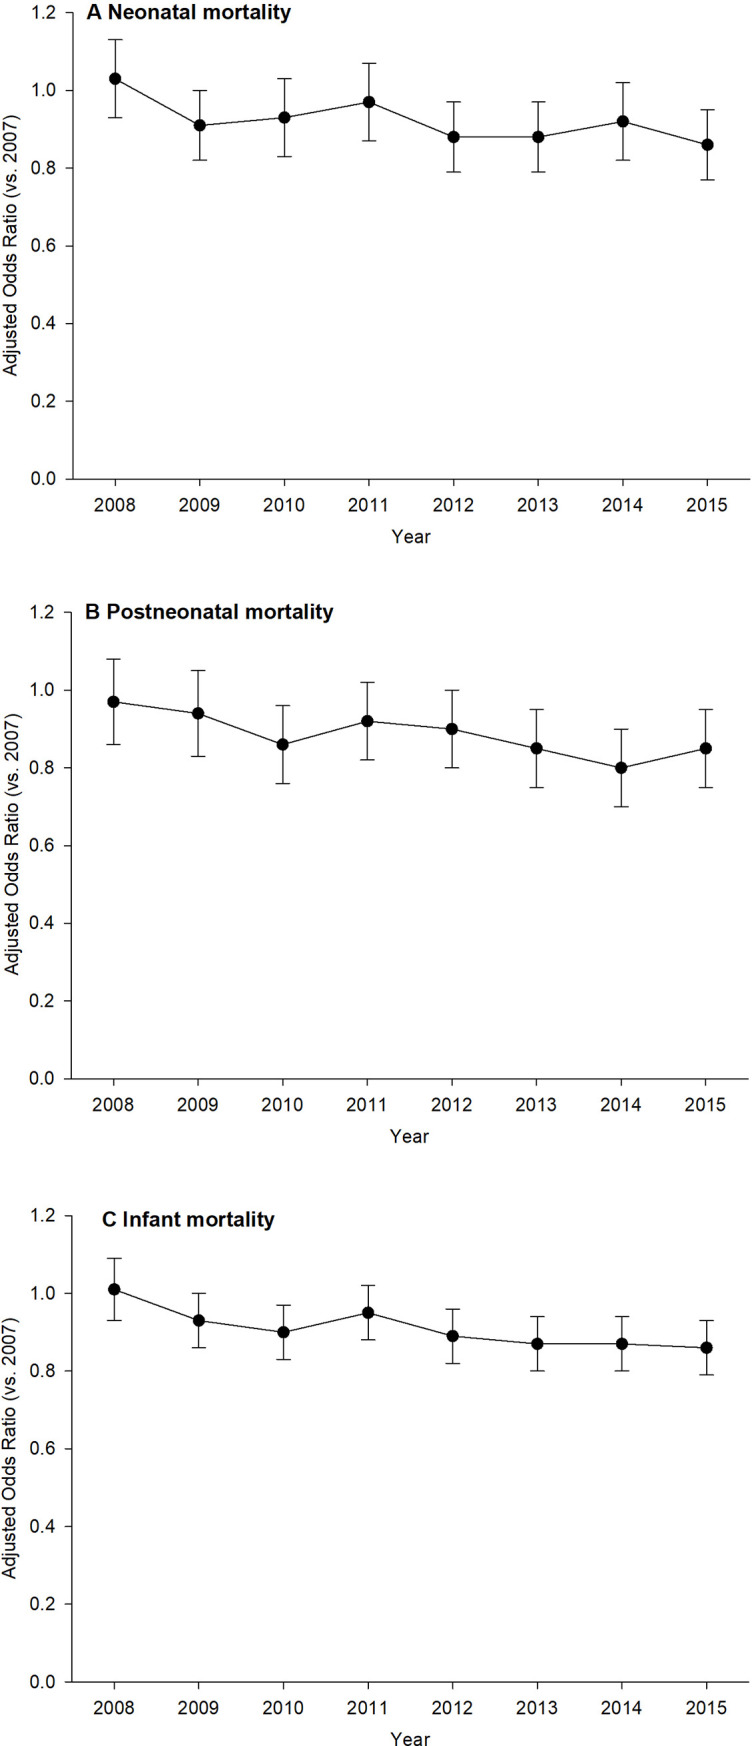
Adjusted odds ratio (with 95% confidence interval in error bars) for A) neonatal mortality (p = 0.014), B) postneonatal mortality (p = 0.008), and C) infant mortality (p <0.001), for singleton births in California for the period 2007–2015. Models were adjusted for maternal demographic characteristics, prepregnancy obesity, smoking during pregnancy, delivery mode, birth weight (grams) and gestational age (weeks). Year 2007 is the reference group. The selected model for the neonatal, postneonatal, and infant mortality showed a concordance index of, c = 0.886, 0.757, and c = 0.826, respectively.